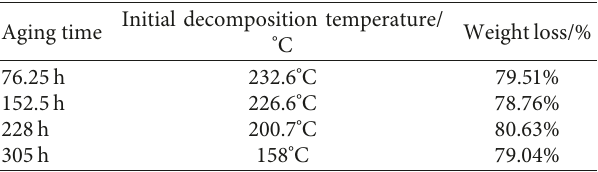
Figure 9: TG test results of 70# base asphalt under different UV aging times. Table 3: TG evaluating indices of 70# base asphalt under different UV aging times.